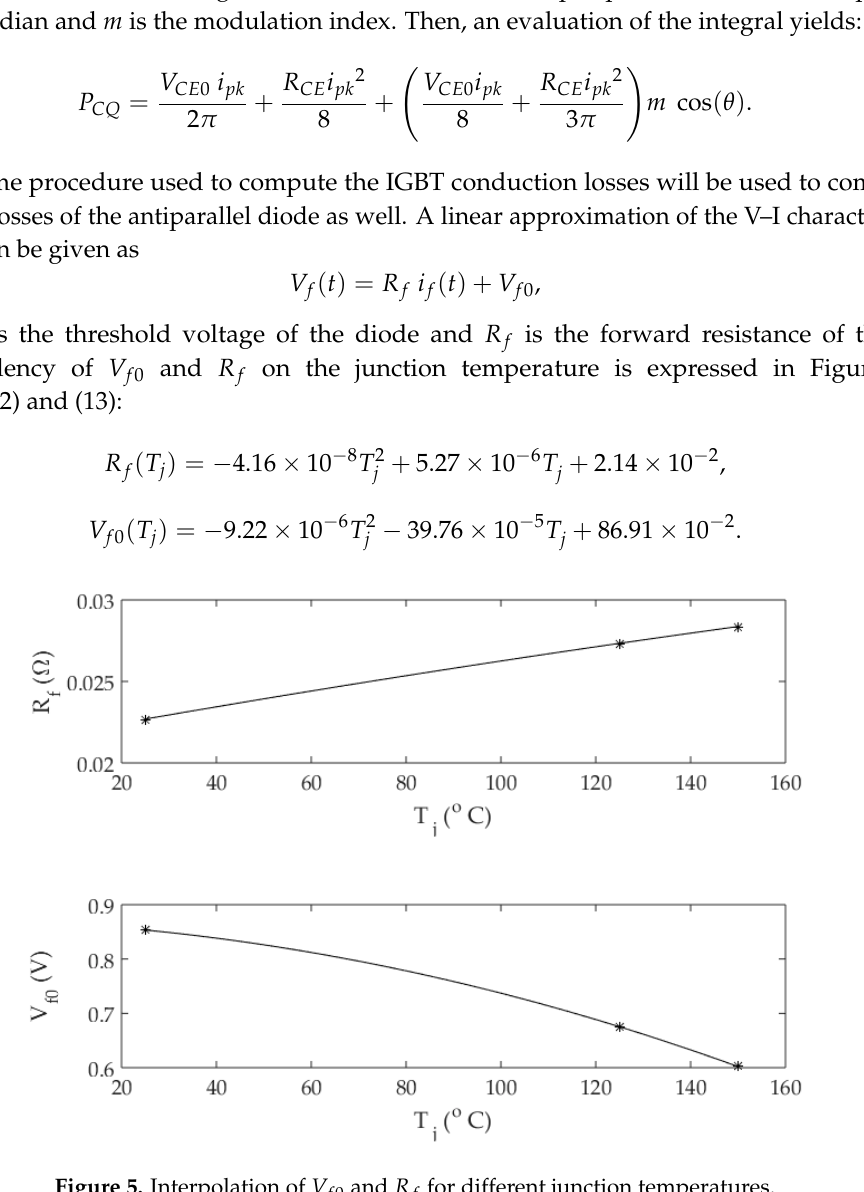
Figure 5. Interpolation of V f 0 and R f for different junction temperatures.